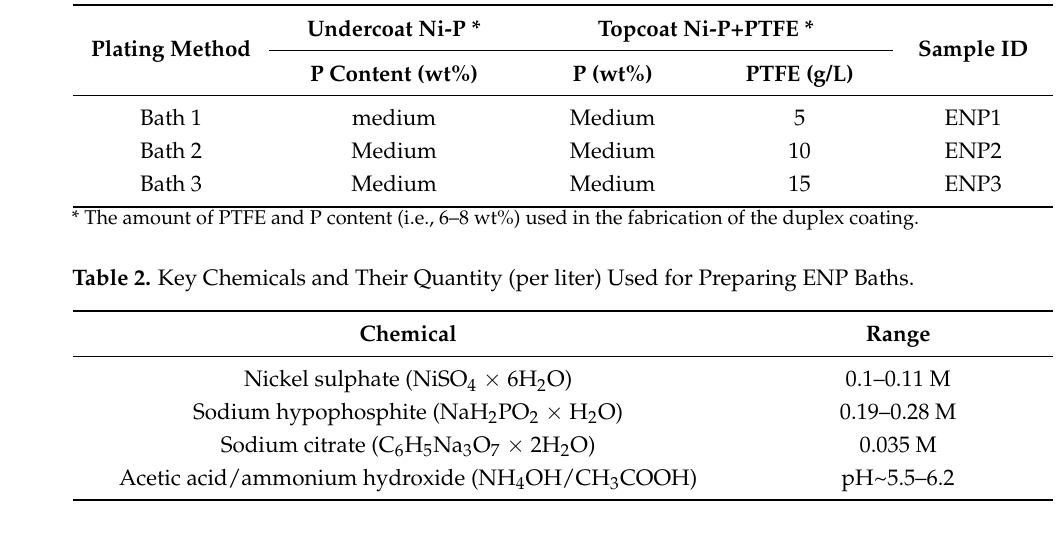
Table 1. A Summary of The Plating Characteristics Used in ENP Duplex Layer Development.